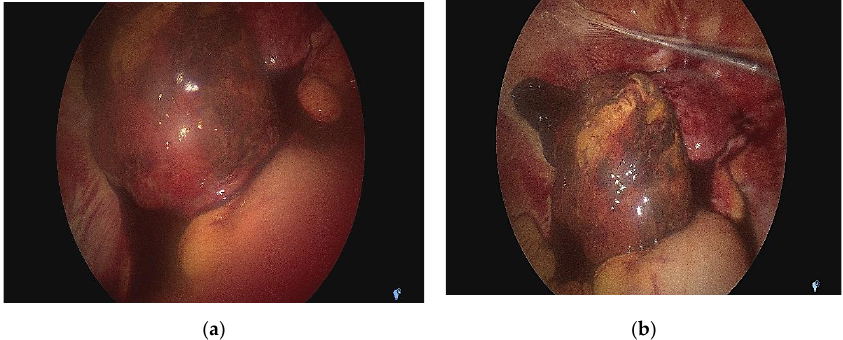
5 of 11 Figure 4. MRI examination: coronal T2-weighted ( a ), axial T2-weighted ( b ) sagittal T2-weighted ( c ) — show the ectopic pregnancy on the left ovarian topography. Given the paraclinical and clinical context — the uncertainty of the positive diagnosis of the exact anatomical location of the pregnancy and accentuation of the abdominal pain — we decided to perform an exploratory laparoscopy in the multidisciplinary team (digestive and vascular surgeons) after obtaining informed consent. We actually found